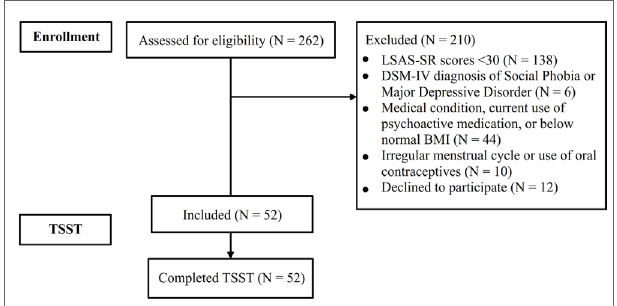
FigUre 1 | Flow diagram describing the participant recruitment process for this study. Abbreviations: BMI, body mass index; LSAS-SR, Liebowitz Social Anxiety Scale (self-report); TSST, Trier Social Stress